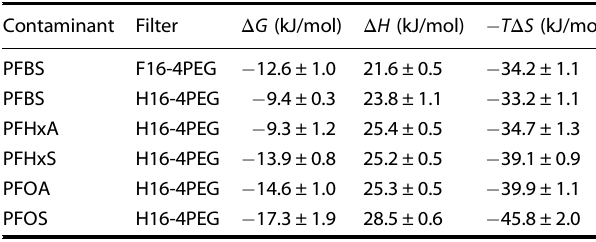
Total free energies of binding decomposed into enthalpic ( Δ H) and entropic contributions ( − T Δ S) for selected contaminant – fi lter pairs, as estimated using molecular dynamics